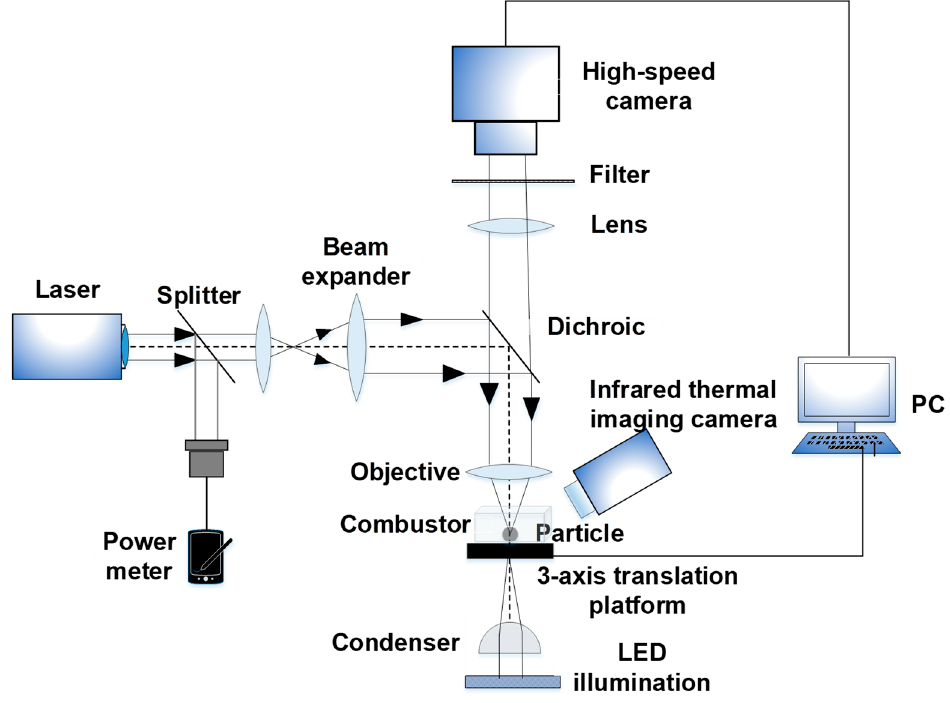
Figure 1. Schematic of experimental apparatus.